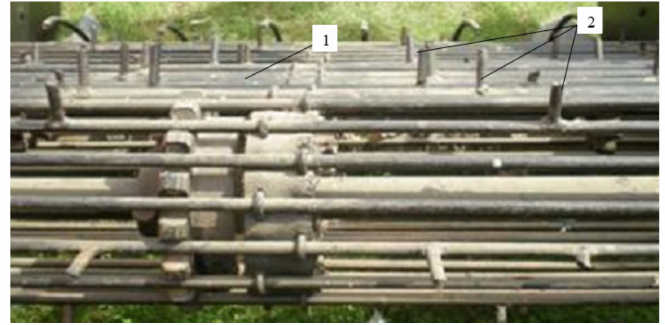
Figure 3. General view of the separating rod elevator: 1, rod; 2,